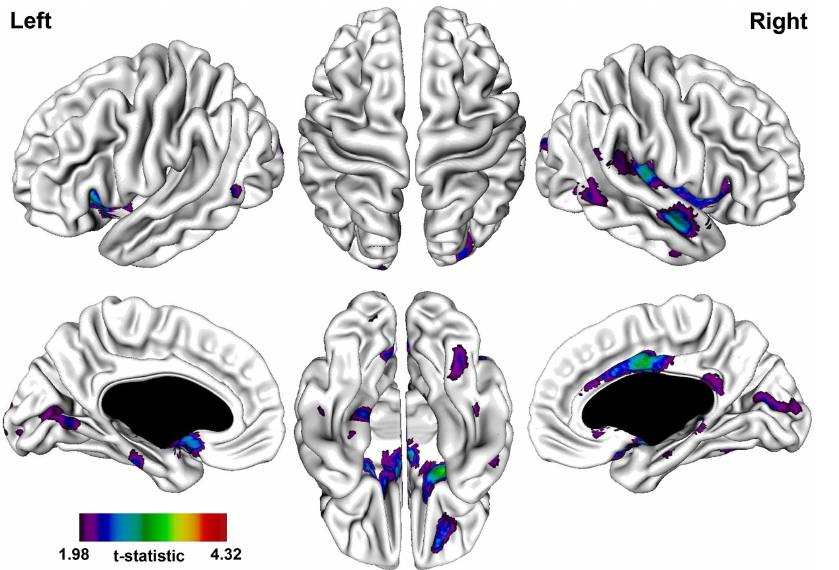
Figure 2. t-statistical brain maps showing cortical thinning in patients with persistent negative symptoms compared to healthy controls. Most pronounced differences in the right temporal gyrus, right parahippocampal gyrus, and right anterior/middle cingulate. The colour bar indicates the t-value. All areas shown exceed a FDR corrected statistical threshold of P , 0.01.